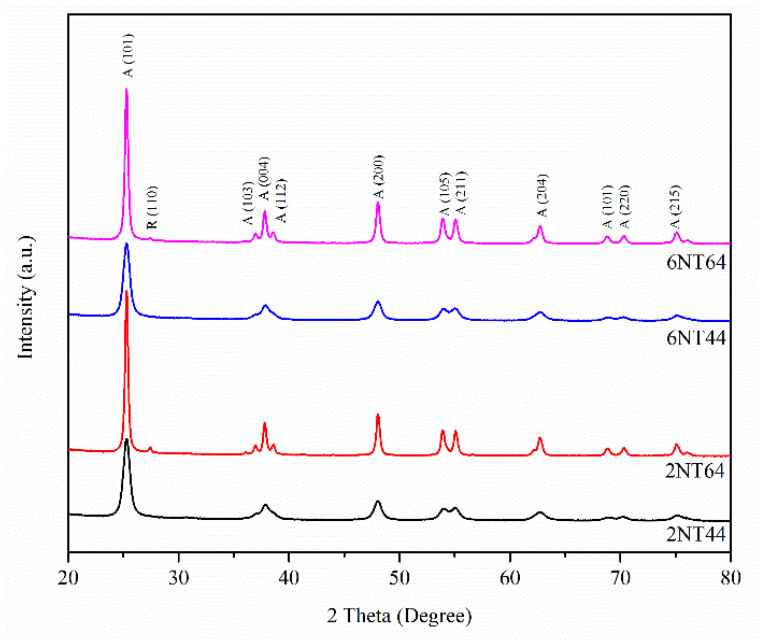
Fig. 3. XRD patterns for different N-doped TiO2 sample.